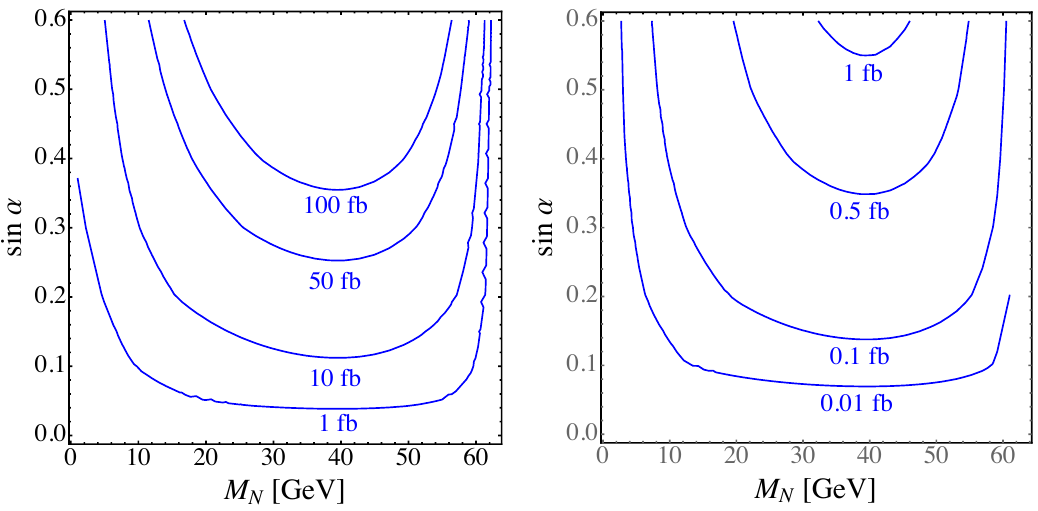
Figure 1 . Left: cross section (cid:27) ( pp h 1 NN ) as a function of the heavy neutrino mass M N ! ! and the Higgs mixing sin (cid:11) at the LHC with a center-of-mass energy of p s = 13 TeV. Right: cross section (cid:27) ( e + e (cid:0) Z Zh 1 Z + NN ) as a function of the same parameters at an ! ! !